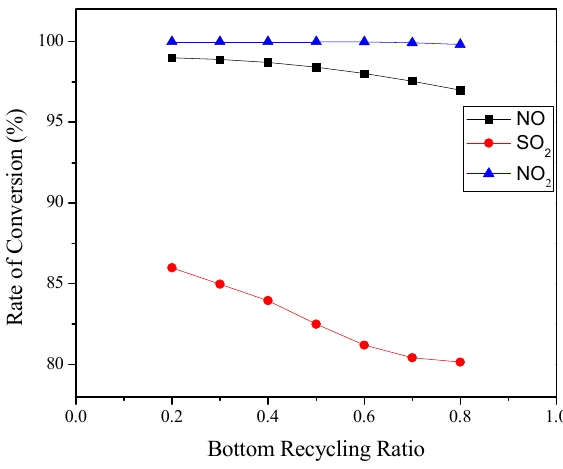
Figure 13. E ff ect of Bottom Recycling ratio on Rate of Conversion Figure 13. Effect of Bottom Recycling ratio on Rate of Conversion (%). Figure 13. Effect of Bottom Recycling ratio on Rate of Conversion (%).